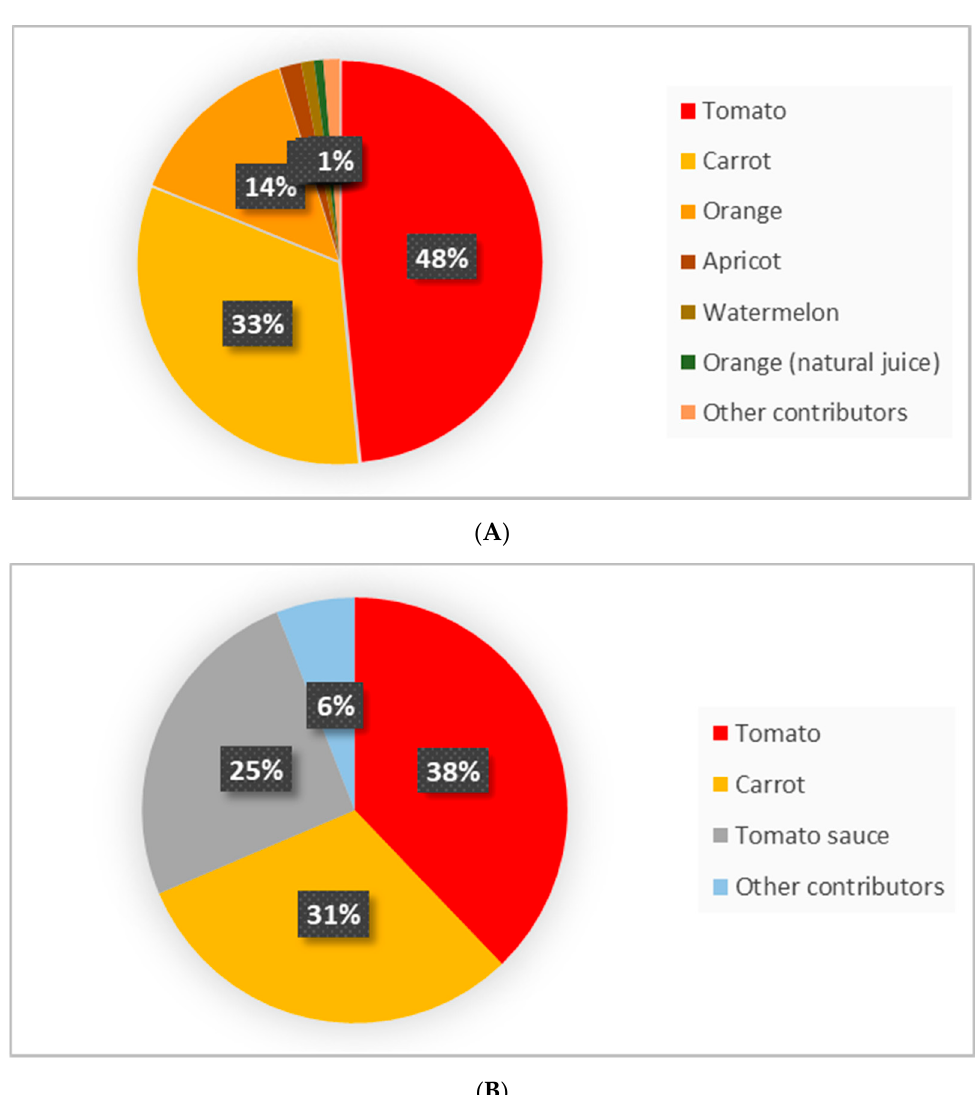
Figure 2. Major contributors to the dietary intake of phytoene ( A ) and phytofluene ( B ).